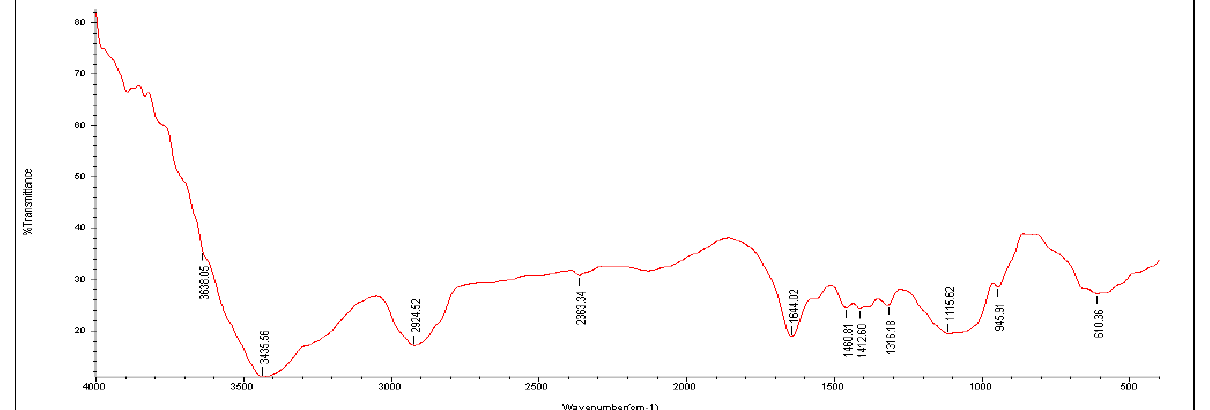
Figure (12) FTIR spectrum of the selected rebamipide ocular insert F3 Differential scanning calorimetry (DSC)